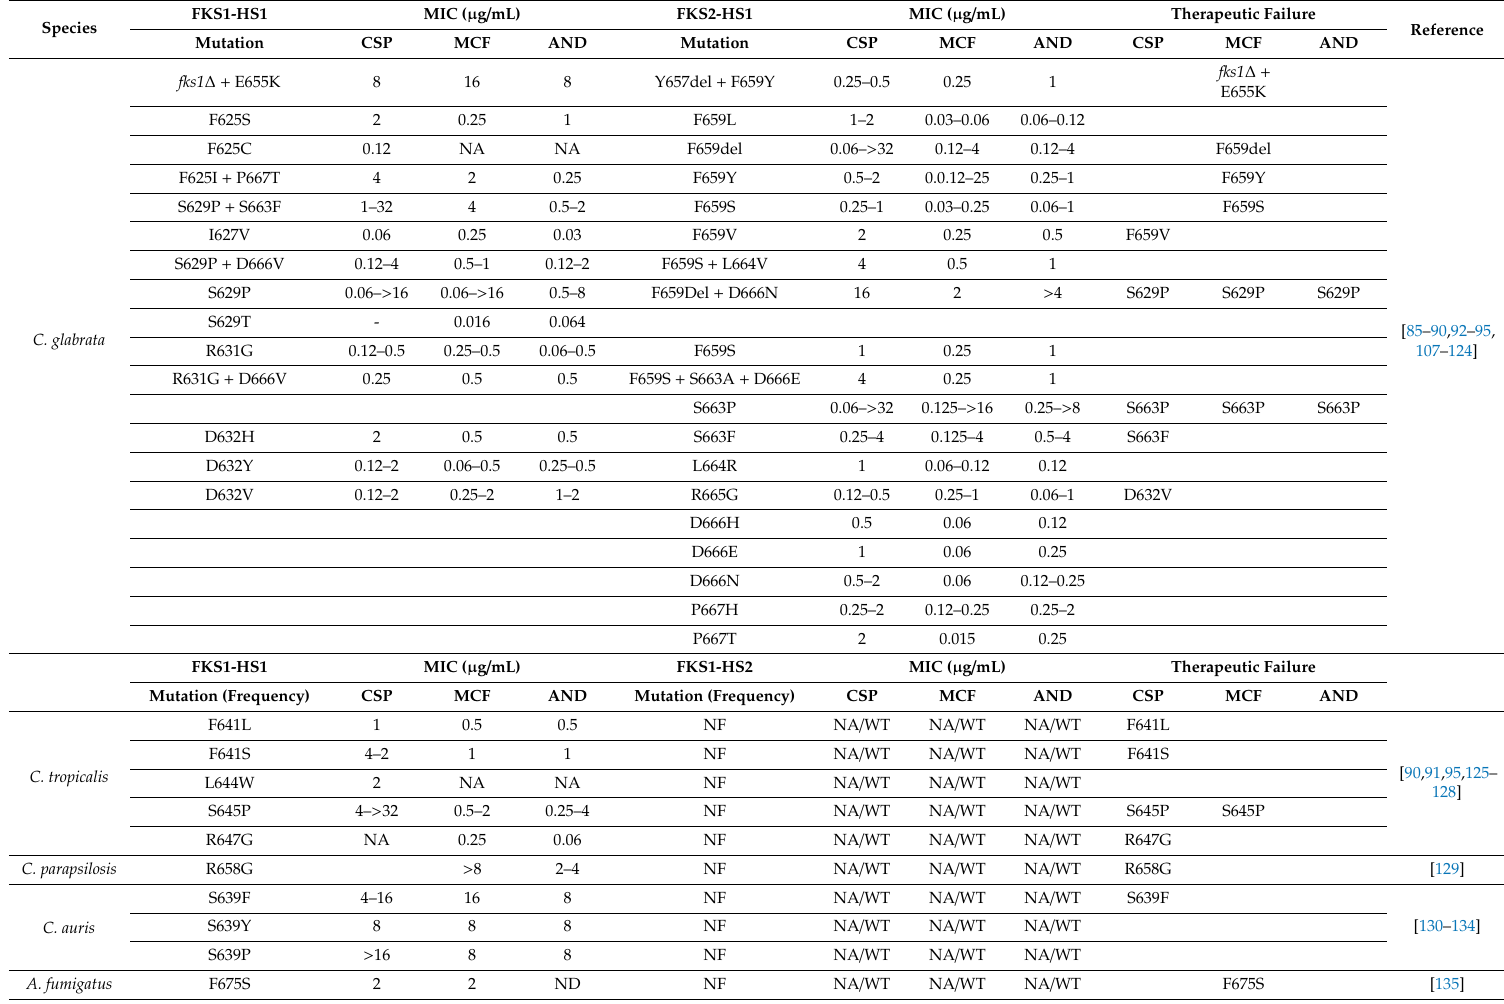
Table 1. Mutations involved in echinocandin resistance and their in vitro and in vivo